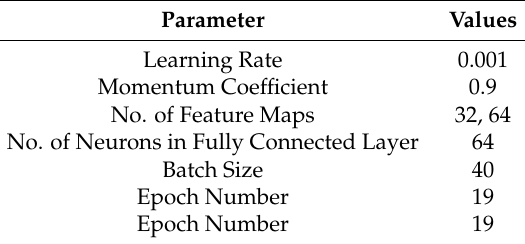
Table 2. CNN predefined